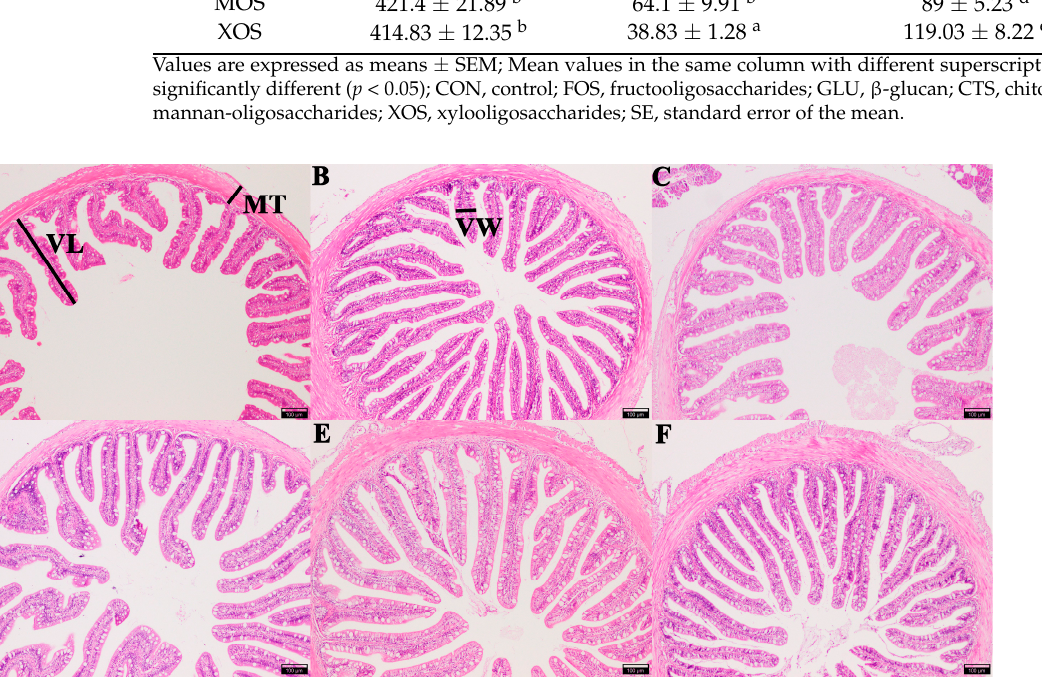
Figure 4. Histological examination images of the intestine in hybrid grouper-fed diets containing different prebiotics (magnification × 100). ( A ) CON; ( B ) FOS; ( C ) GLU; ( D ) CTS; ( E ) MOS; ( F ) XOS. Measured intestinal morphological parameters: villus length (VL), villus width (VW), and muscle thickness (MT). Scale bar: 100 µ m. CON, control; FOS, fructooligosaccharides; GLU, β -glucan; CTS, chitosan; MOS, mannan–oligosaccharides; XOS,